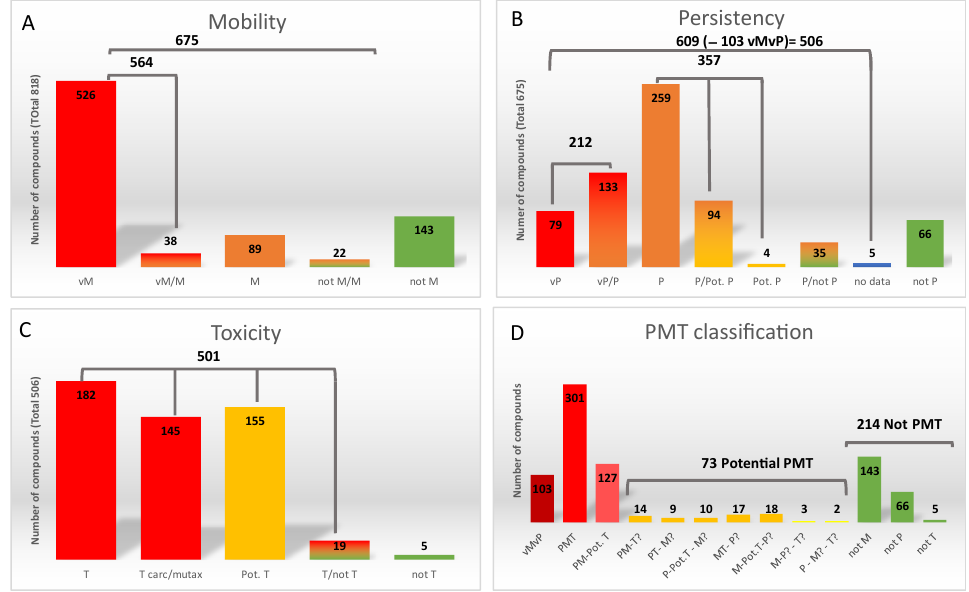
Figure 1. Results of the prioritization strategy. ( A ) Mobility classification, ( B ) persistency classification, ( C ) toxicity classification, ( D ) PMT criteria classification.